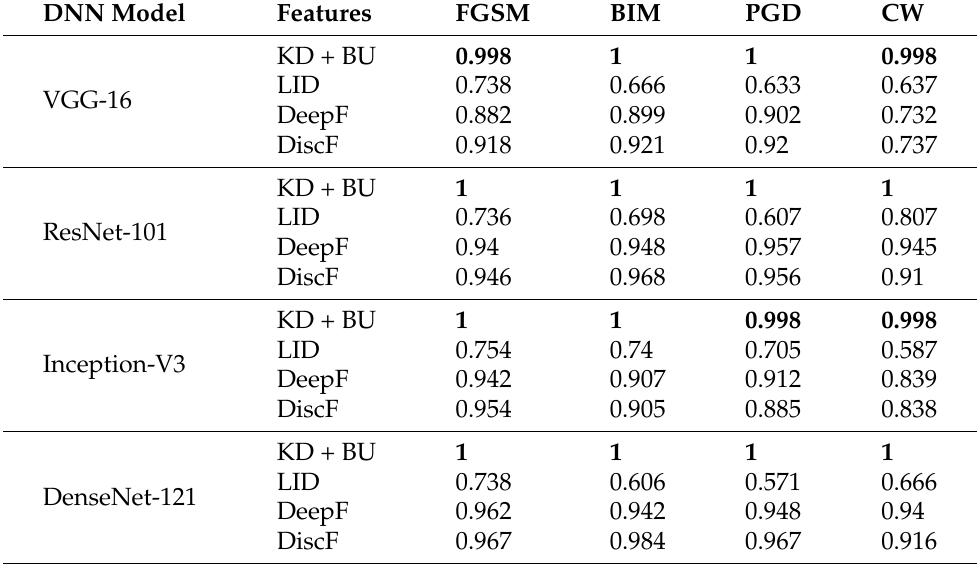
Table 3. Adversarial sample detection results for 2-class DNN models using different